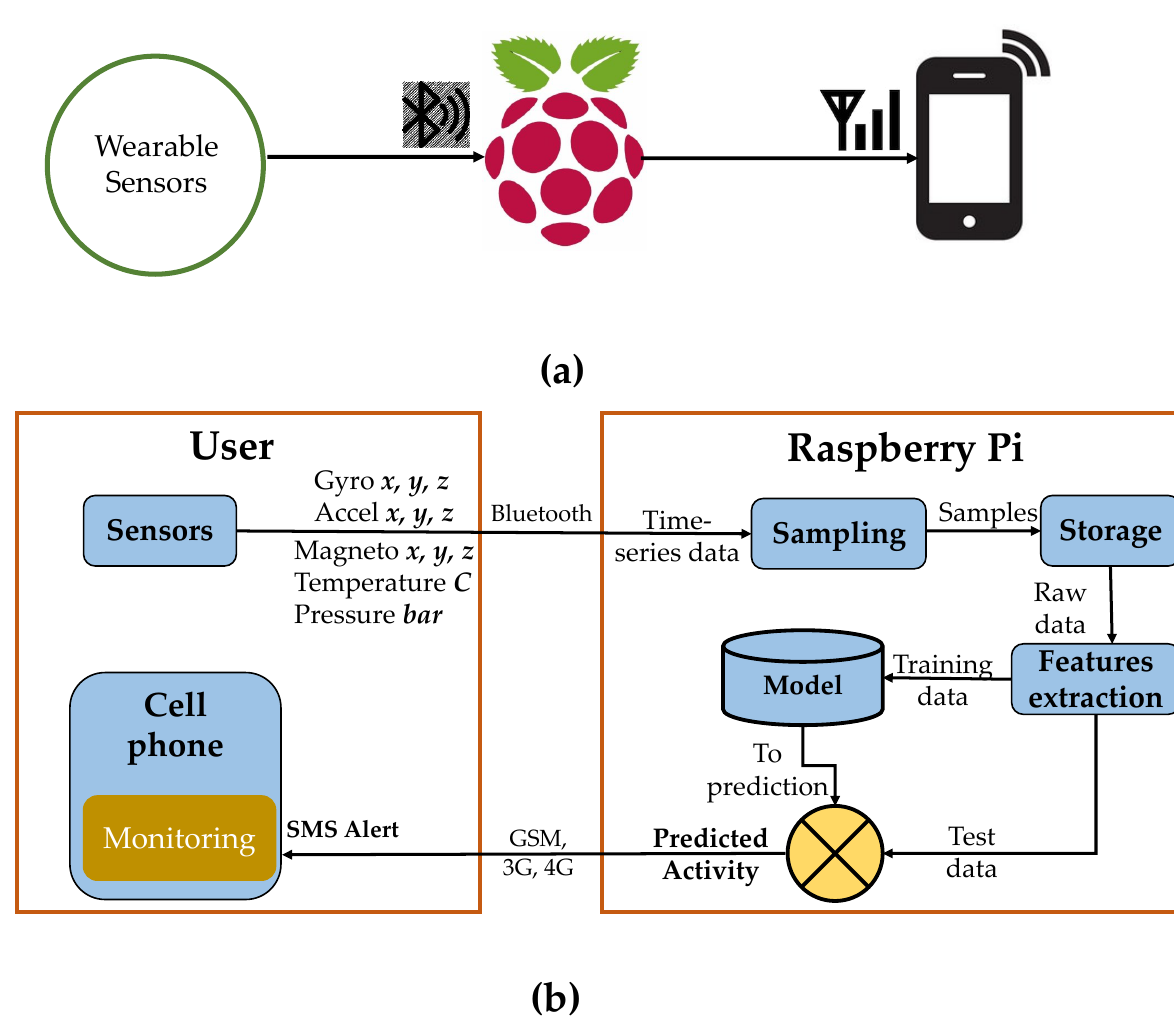
Figure 1. ( a ) Hardware and ( b ) software overview of the proposed